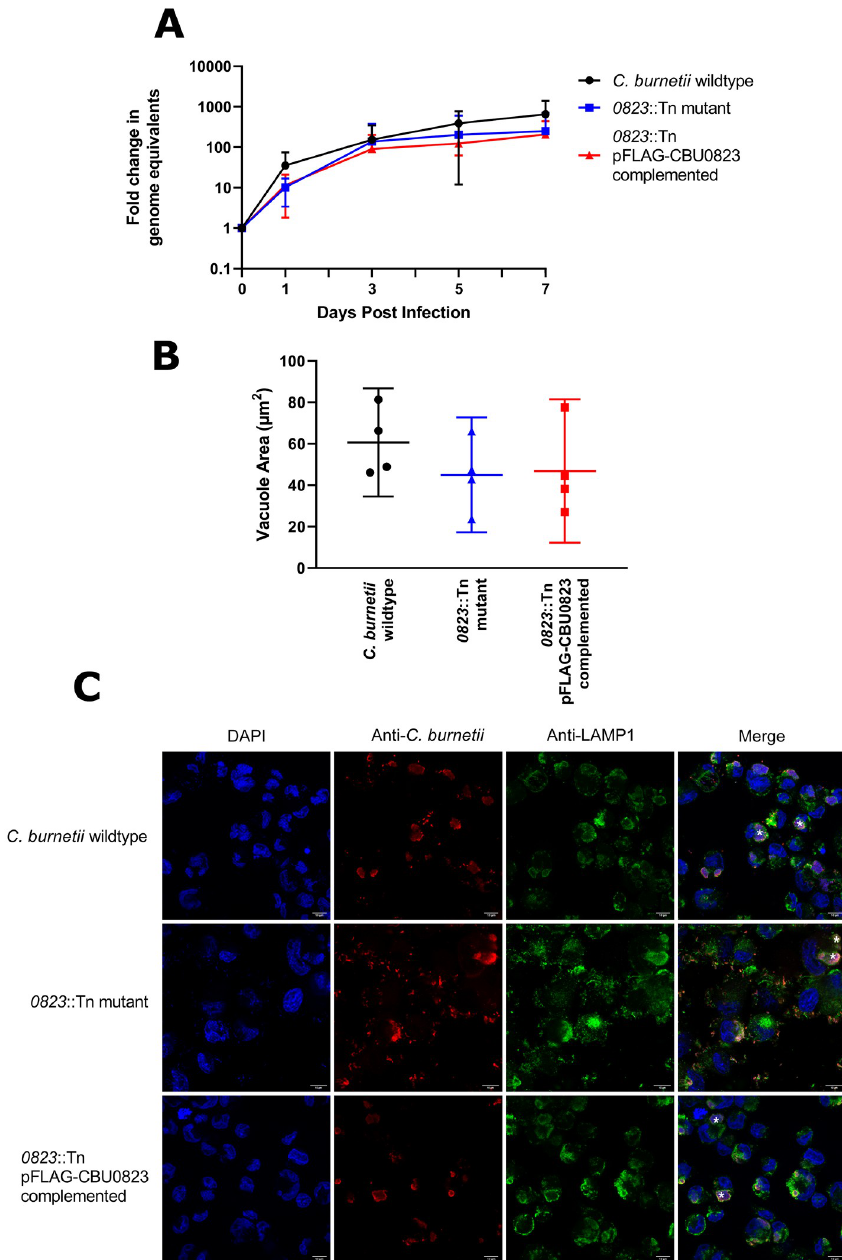
Fig 9. cbu0823 is not required for efficient intracellular replication of C . burnetii in THP-1 cells. Intracellular replication within THP-1 macrophage-like cells of C . burnetii wildtype, 0823 ::Tn mutant and 0823 ::Tn pFLAG-CBU0823 complemented mutant strains over 7 days depicted in fold change of genome equivalents (GE) measured by qPCR for ompA . (A) Fold change in GE was plotted over 7 days as mean with error bars representing standard deviation from six independent biological replicates. There was no difference in replication between strains ( p > 0.05). (B) Average vacuole area, measured in μ m 2 on representative immunofluorescent images of each strain and plotted as mean with error bars representing standard deviation for four of the six replicates. There was no significant difference between the three strains ( p > 0.05). (C) Representative confocal immunofluorescent micrographs of THP-1 cells 3 days post-infection with C . burnetii wildtype, 0823 ::Tn mutant and 0823 ::Tn complemented mutant strains. There were no significant differences in CCV size and organism numbers between strains. Anti- Coxiella antibody (red), anti-LAMP-1 antibody (green) and DAPI (blue) were used to stain cells and white asterisks indicate CCVs. The scale bar depicts 10 μ m.